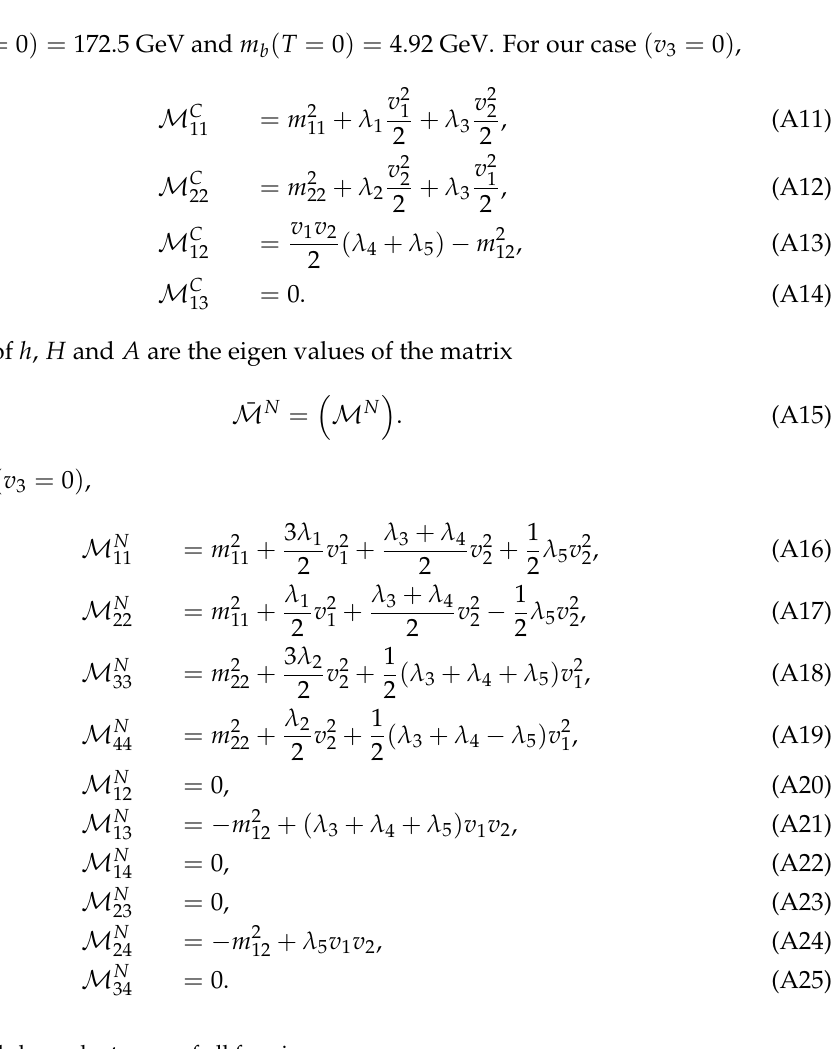
Table A1. Field-dependent mass of all